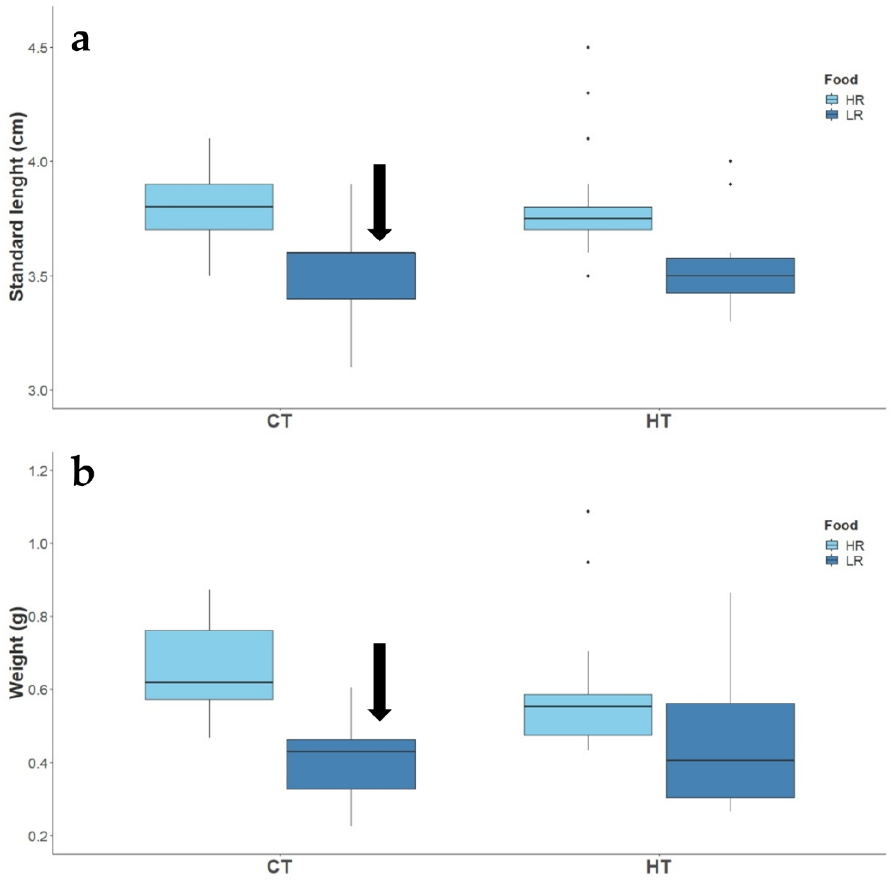
Figure 5. Effect of temperature (CT and HT) and food availability (HR, LR) on the standard length ( a ), and weight ( b ), of adult two-spotted goby, Pomatochistus flavescens, at the end of the exposure period. Black arrows indicate significant treatment effects ( p ≤ 0.05) as compared to CT + HR treat- ment.